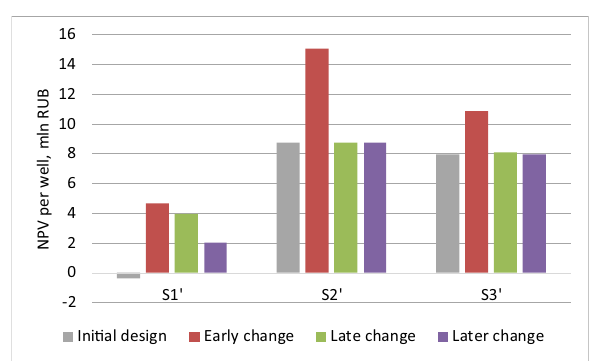
Fig. 14 Probability distribution functions (PDF) for the well drill- ing time, the starting oil flow rate and the oil production decline rate (the staring oil flow rate is distributed around three values 20, 50 and 90 tn/day, and only one distribution around 50 tn/day is shown)